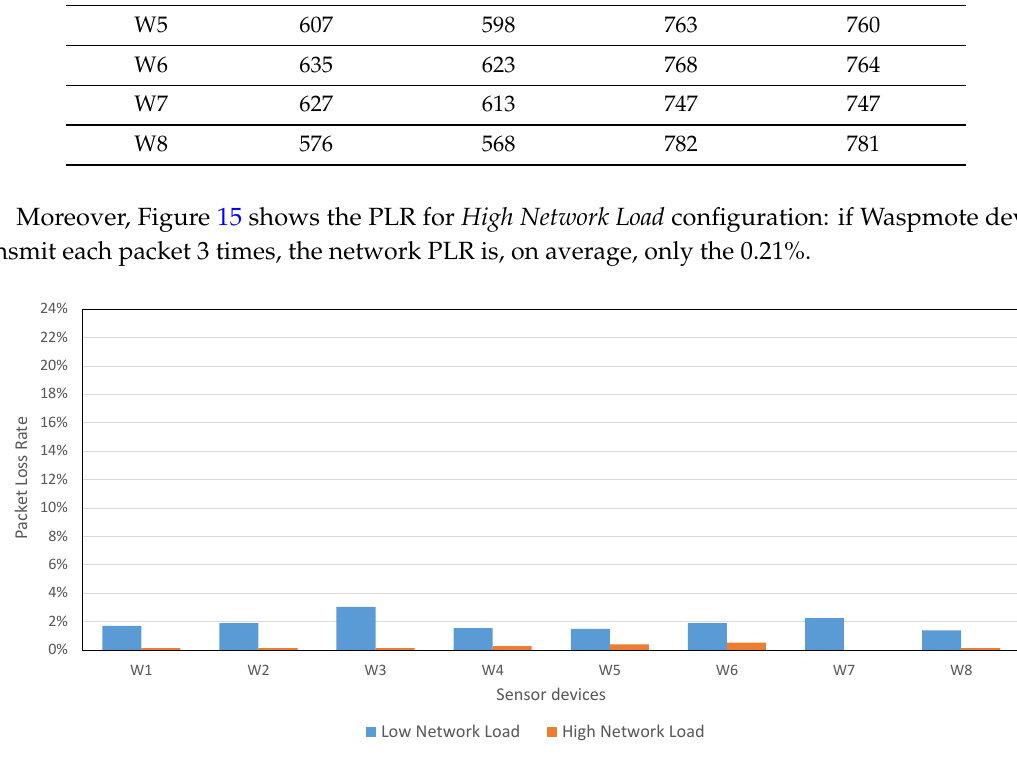
Figure 15. PLR in our mesh proposal for 8 sensor devices with Individual Mesh configuration and 3 CSR devices with default configuration.